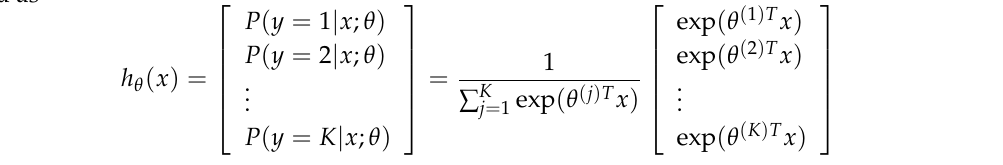
Table 2. Sampling was done in three phases: the baseline phase, the sampling phase, and the recovery phase. Each test lasted for 50 s. All the measurement data were stored on computer for future processing and analysis. The gases were collected in a closed, controlled environment with an ambient temperature of 25–27 degree Celsius and 50% RH ambient humidity. The experiment for each target odor was carried out 50 times. We eventually acquired 150 samples in